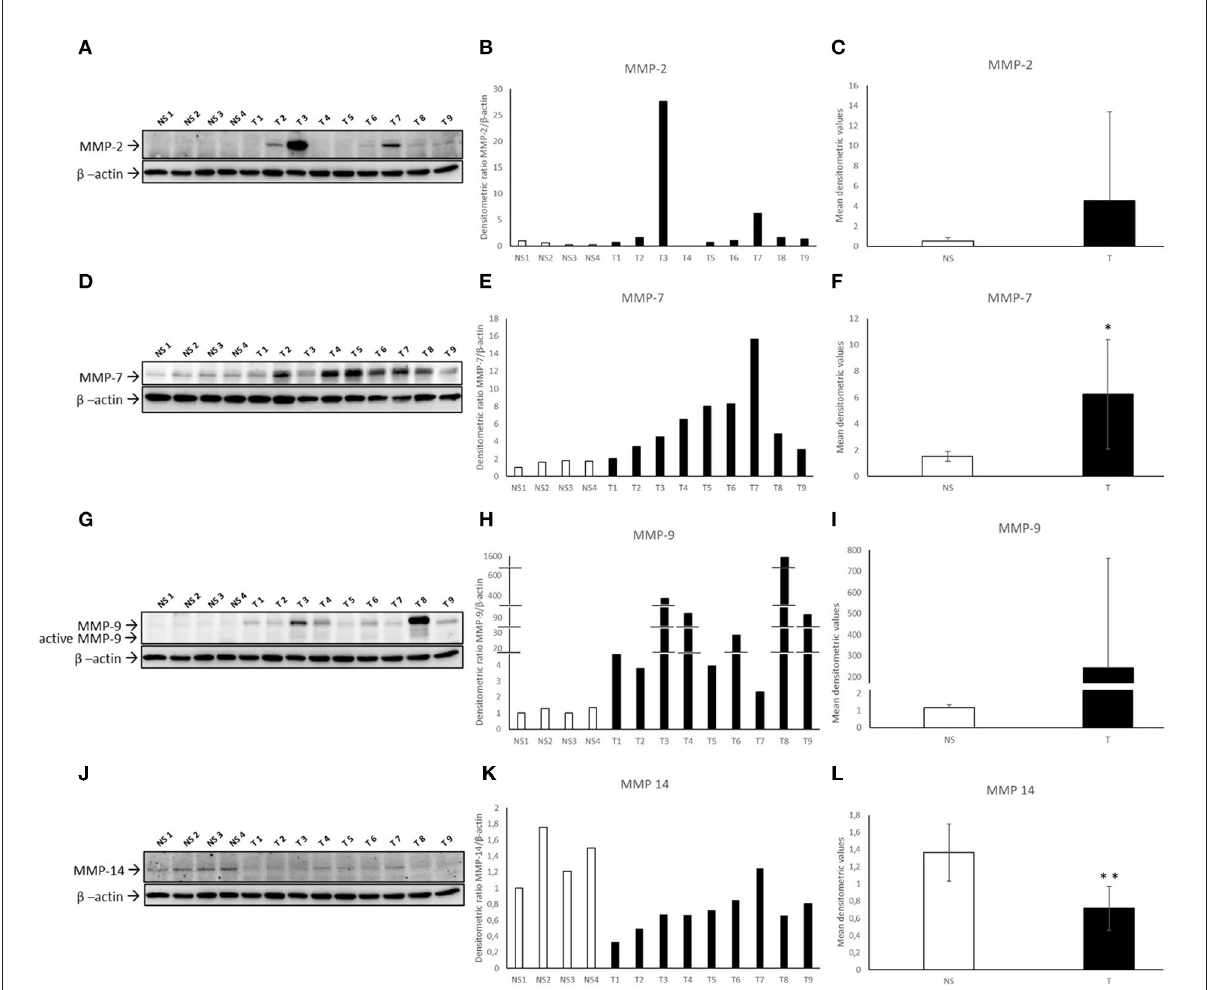
FIGURE8 Western blotting analysis of MMP-2/-7/-9/-14 in bovine normal skin (NS) and fibropapillomas (T). Western blotting and densitometric measurements of MMP-2/-7/-9/-14 in NS1-NS4 and T1-T9 samples (A–L) . Representative gels showing an increased amount of MMP-2/-7/-9 (A,D,G) and decreased expression of MMP-14 (J) in tumor compared with normal skin samples are shown. The blots were stripped and reprobed with anti- β -actin antibody to confirm equal loading of proteins in each lane and allow normalization. (B,E,H,K) Individual densitometric values of MMP-2/-7/-9/-14 for each sample expressed as densitometric ratio with β -actin. (C,F,I,L) Mean densitometric values + /- standard deviations for MMP-2/-7/-9/-14 in NS vs T groups (*: statistically significant by t -test, P < 0.05; **: statistically significant by t -test, P <